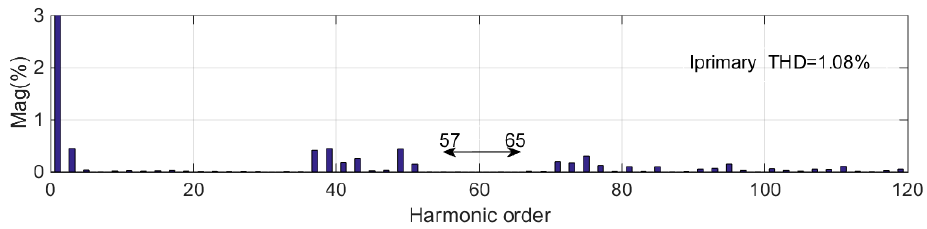
Figure 28. Fourier analysis of transformer primary current with SHE-PWM algorithm.